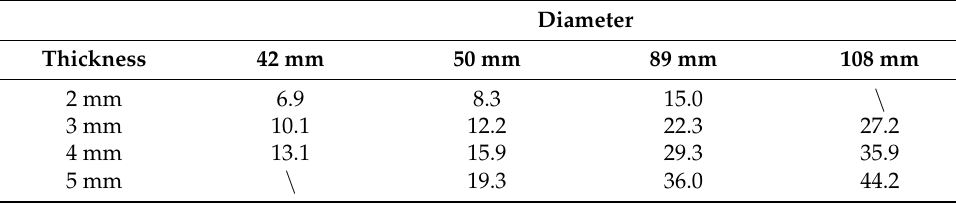
Figure 4. Deformation-load characteristics of FLSPs with different diameters. Table 1. Weight of single FLSPs of different models (unit: